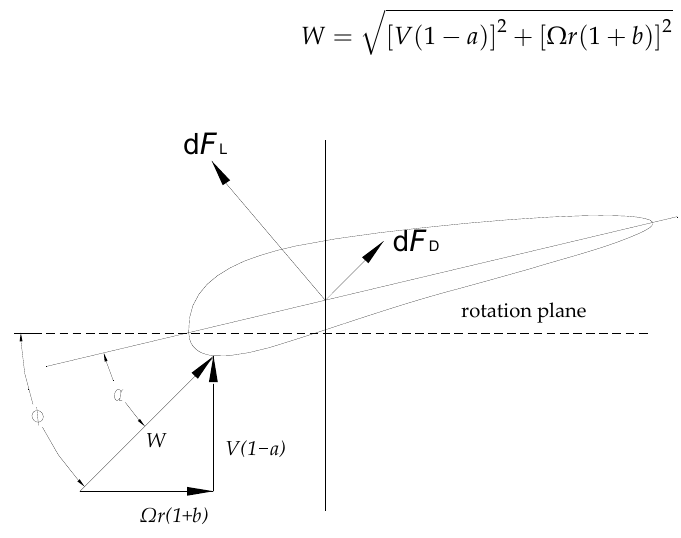
Figure 2. ( a ) Water turbine with high solidity [3]. ( b ) Water turbine with low solidity [3].